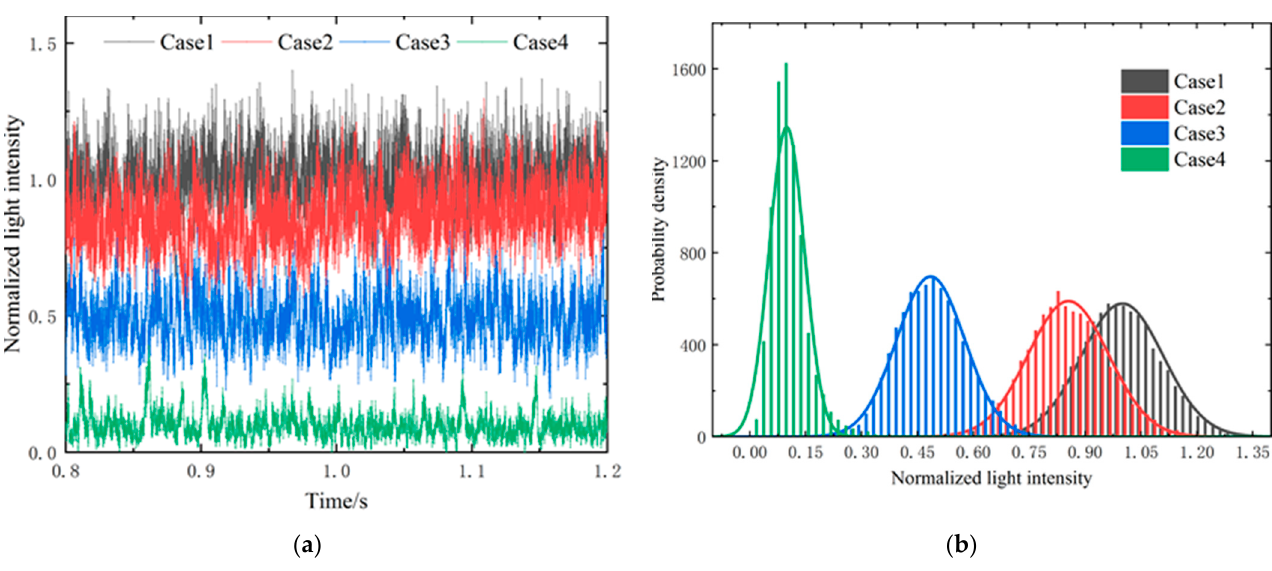
Figure 7. Normalized light intensity under different injection pressure drops after the condition transition. ( a ) Profiles of the normalized light intensities. ( b ) Probability densities of the normalized light intensities.